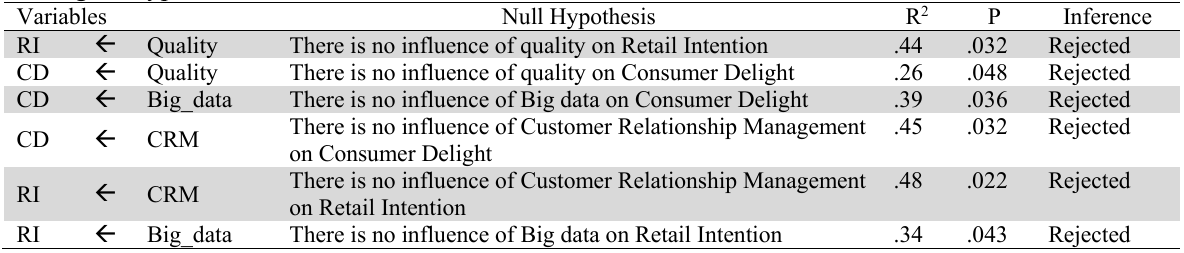
Testing of Hypothesis for the